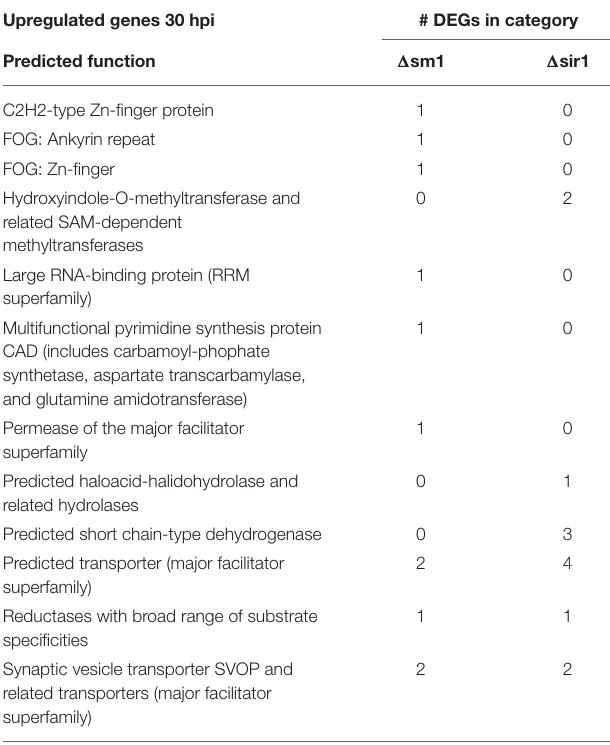
TABLE 4 | Downregulated genes with general function KOGG annotation in 1 sm1 or 1 sir1 at 30 hpi. Downregulated genes 30 hpi # DEGs in category